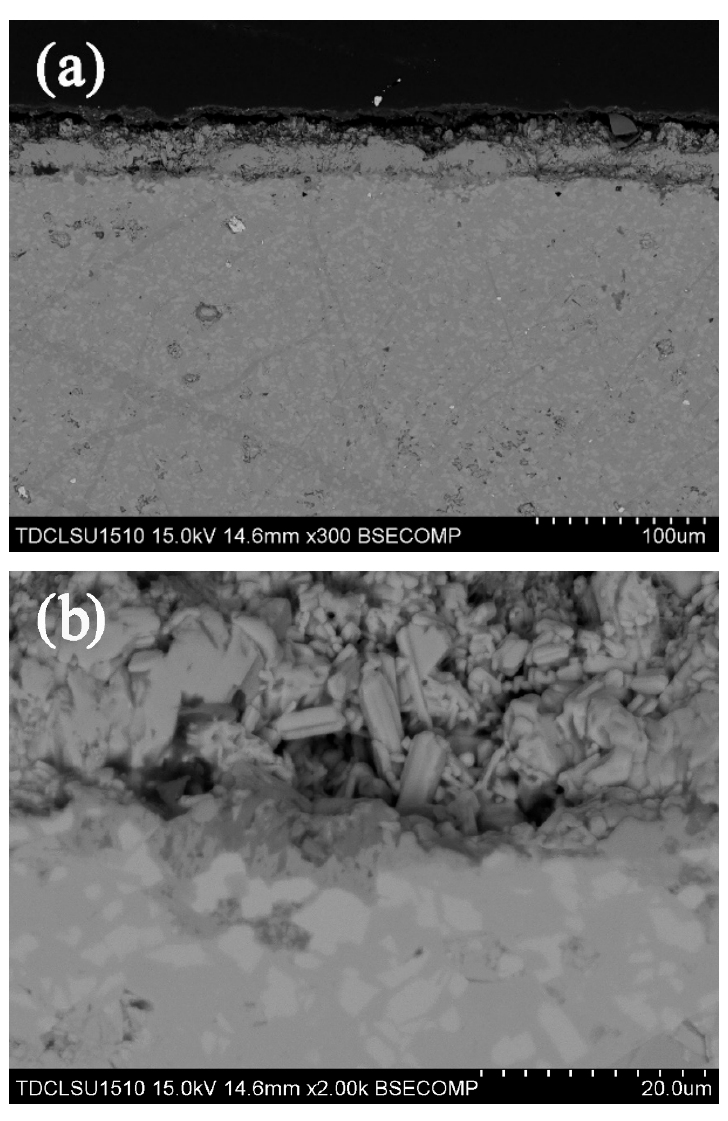
Figure 4. Cross-sectional microstructures of BaNd 2 Ti 3 O 10 pellet after Na 2 SO 4 + V 2 O 5 molten salt corrosion at 900 °C for 4 h. ( a ) and ( b ) show the images with different magnifications.